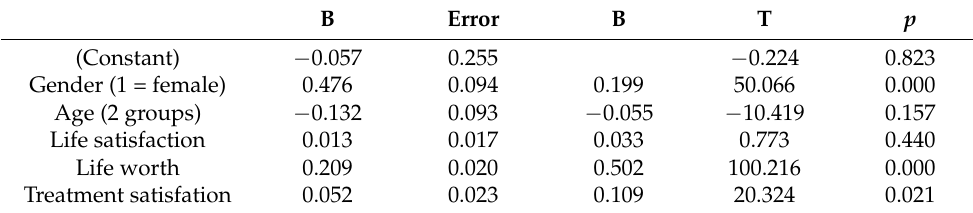
Table 4. Linear regression model to study well-being